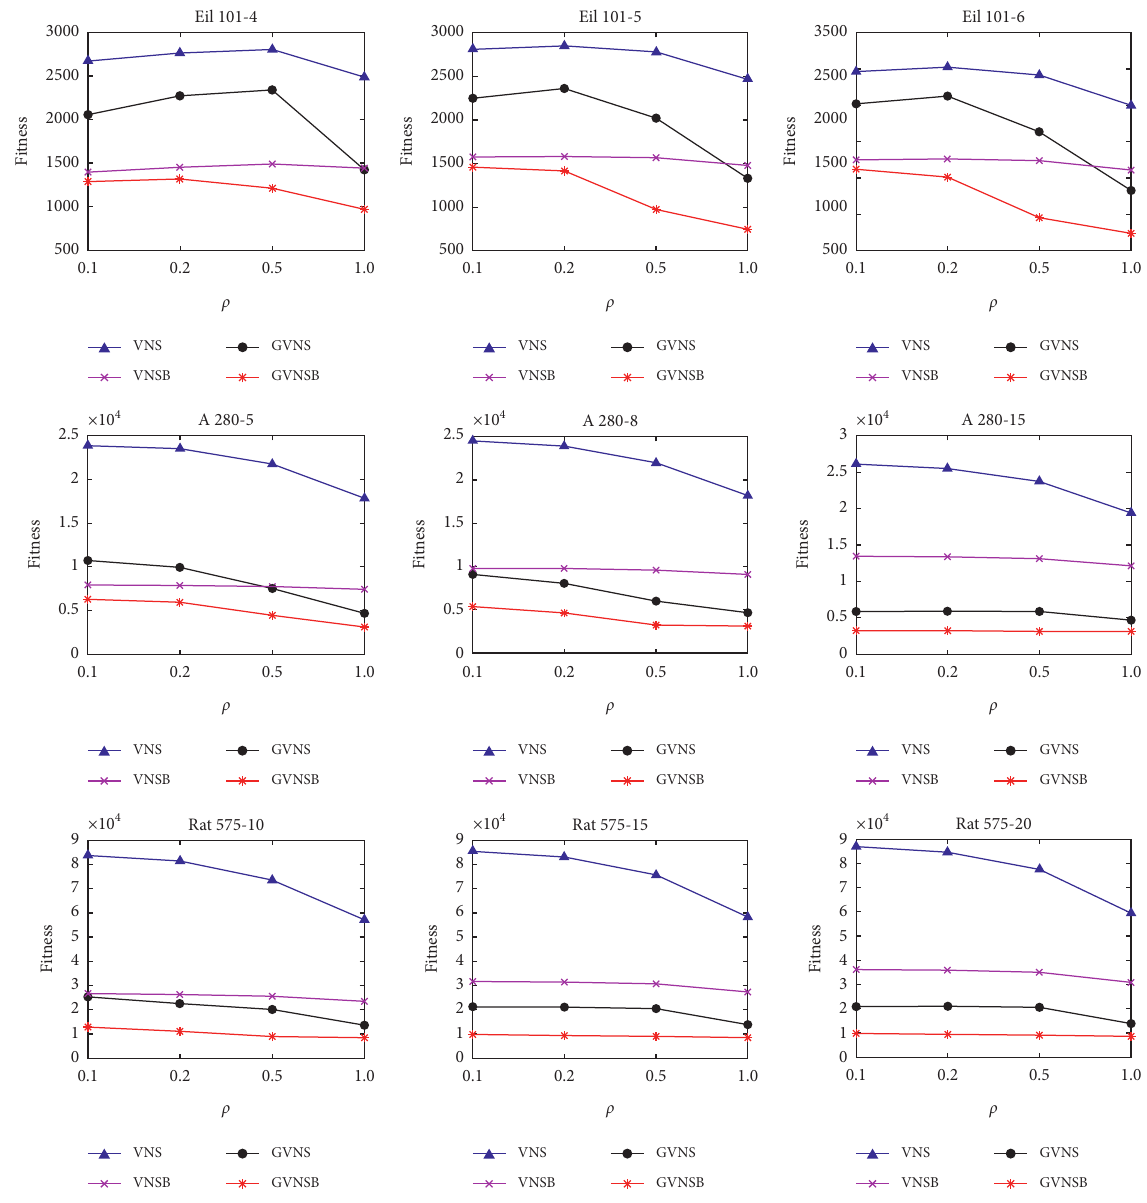
Figure 6: The results of VNSs at environment τ �